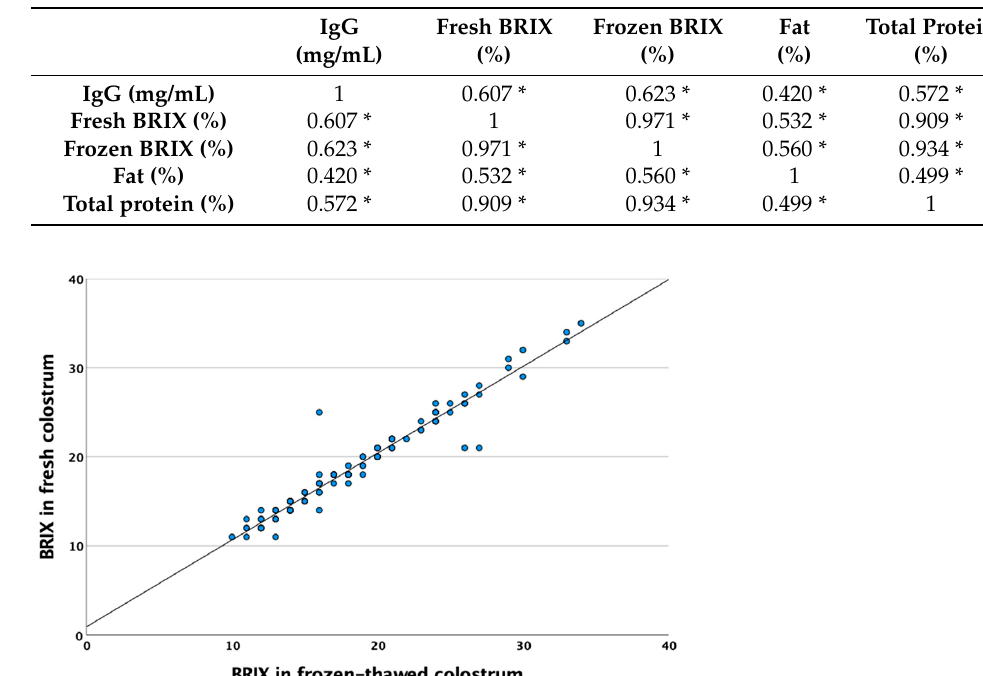
Table 2. Pearson correlation between various colostrum characteristics. Asterisks indicate signifi- cant correlation.